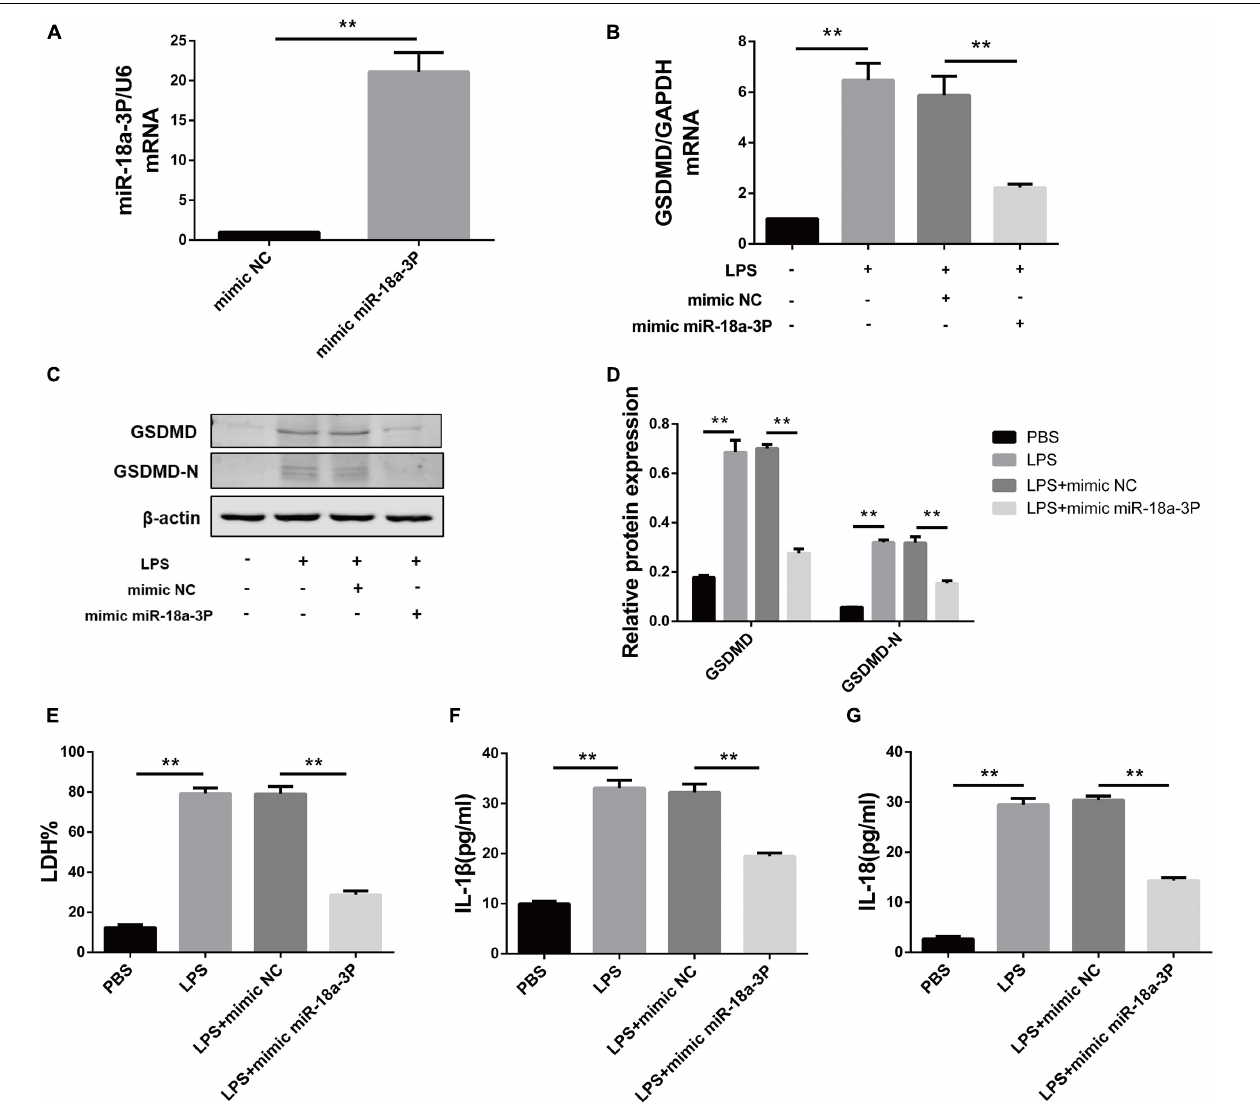
FIGURE 5 | Overexpression of miR-18a-3P inhibits LPS-induced pyroptosis in primary human TECs. (A) Expression level of miR-18a-3p mRNA in TECs transfected with mimic. (B) GSDMD mRNA expression level in TECs transfected with mimic. (C,D) Protein expression levels of GSDMD and GSDMD-N in TECs transfected with mimic. (E) LDH% in supernatants obtained from TECs transfected with mimic. (F,G) Release of IL-1 β and IL-18 in supernatants obtained from TECs transfected with mimic. ** P < 0.01, compared with the respective control